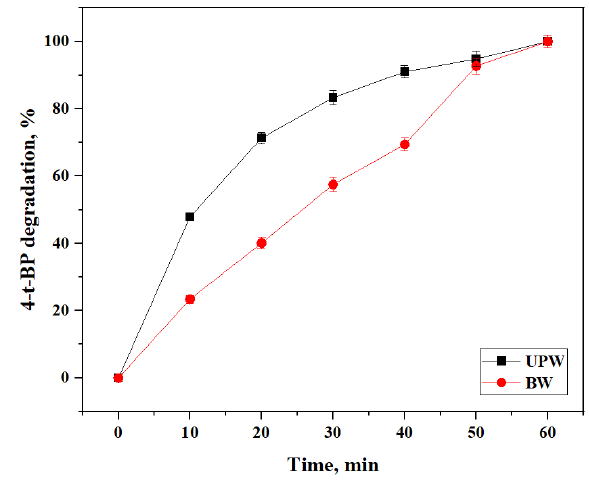
Figure 7. Effect of the type of water on the degradation of 4-t-BP under solar light. Experimental conditions: [4-t-BP] 0 = 5 ppm, catalyst dosage = 200 mg/L. As shown in Figure 8A, the presence of CO 2 − enhanced the 4-t-BP 3